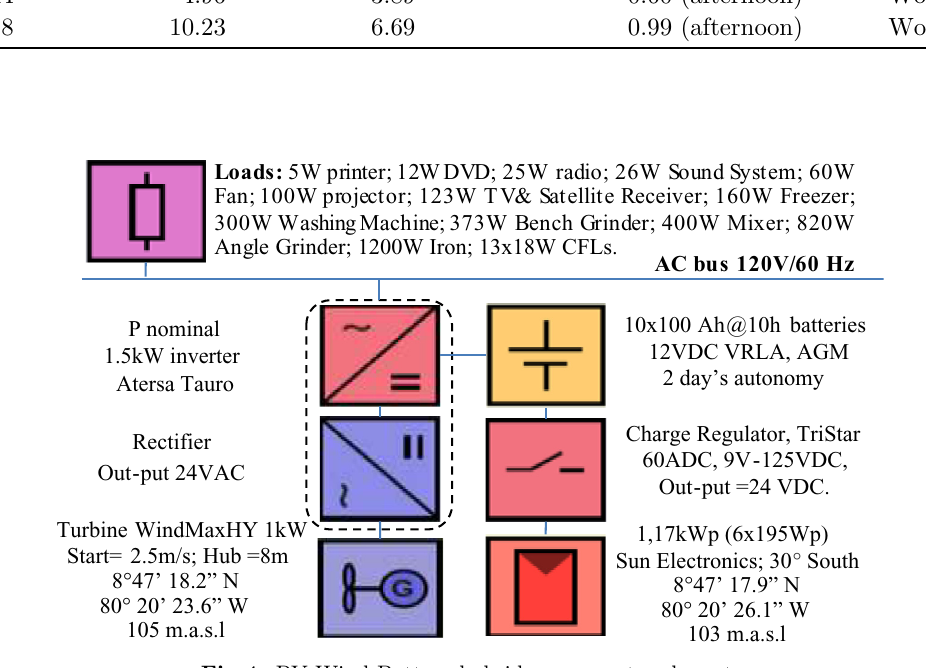
Fig 4. PV-Wind-Battery hybrid power system